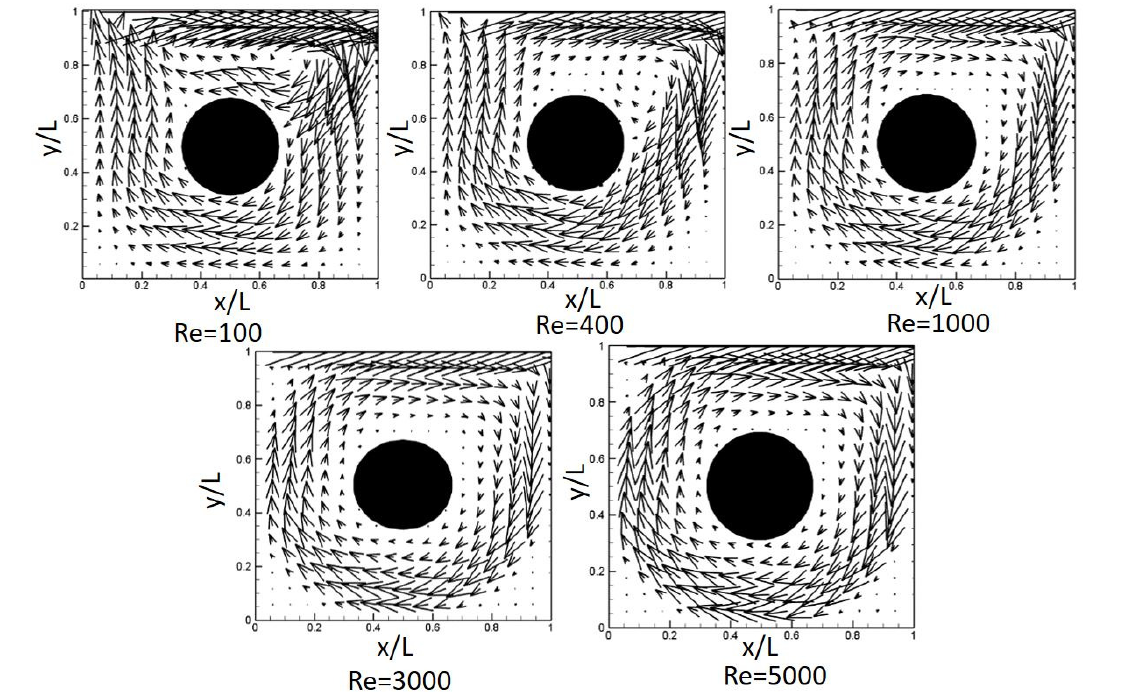
Figure 13. Vector profiles with the changing Re .